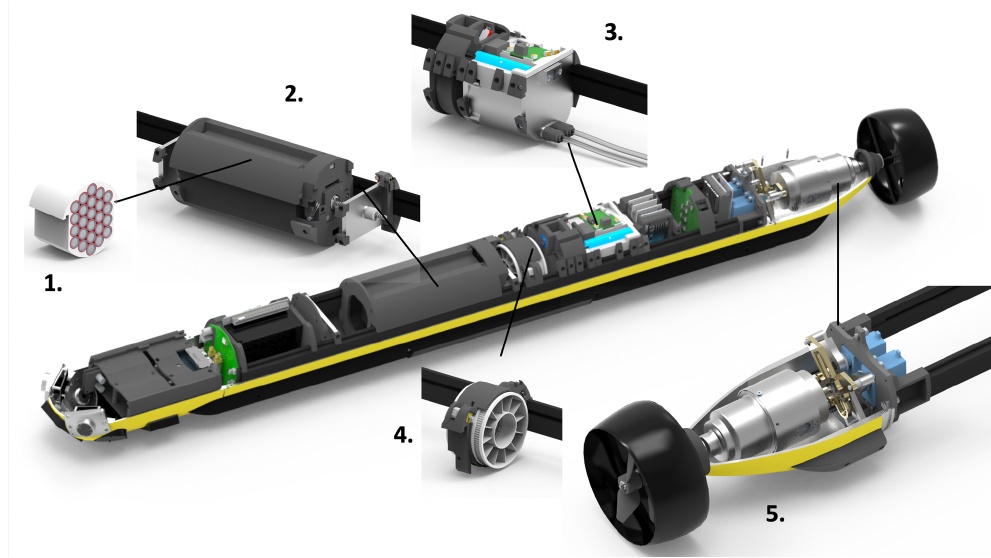
Figure 3. SAM AUV subsystems: 1. battery pack, 2. longitudinal center of gravity trim system (LCG), 3. variable buoyancy system (VBS), 4. transversal center of gravity system (TCG), 5. thrust vectoring system with counter-rotating